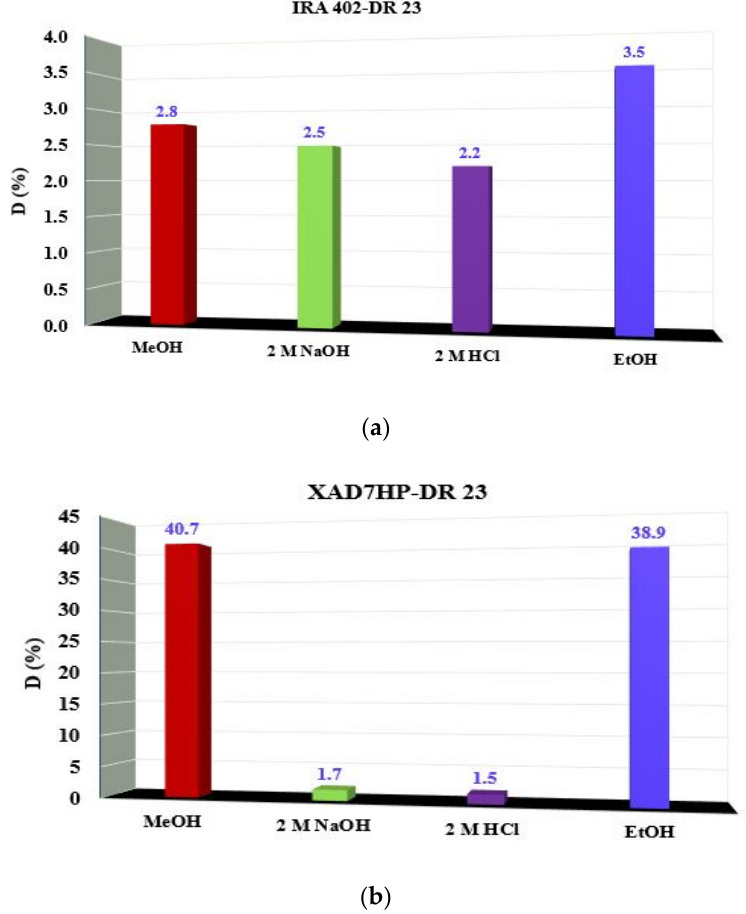
Figure 4. Effect of desorption agents for ( a ) IRA402-DR 23 and ( b ) XAD7HP-DR 23.